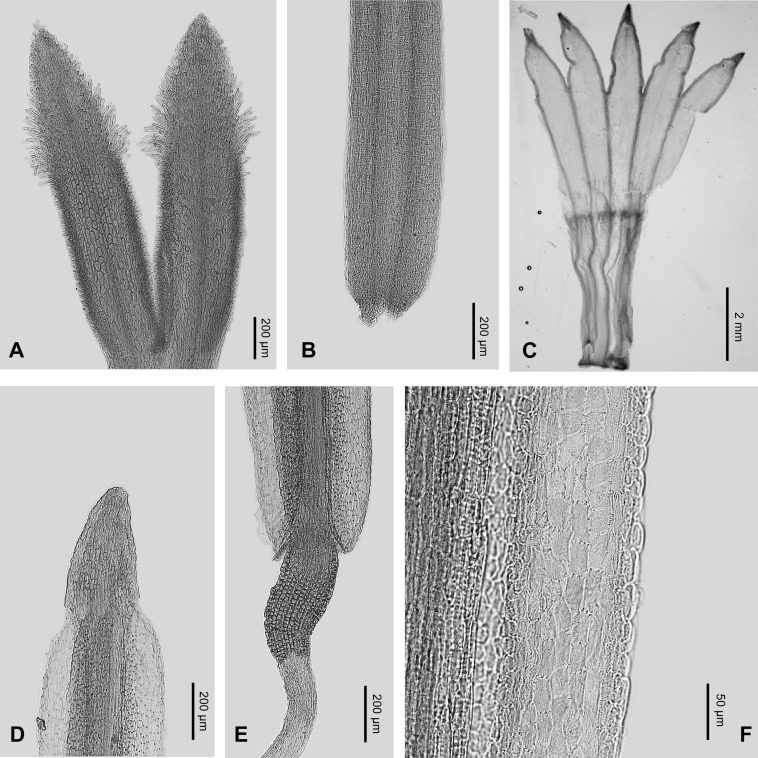
Micro-morphology of Aster dolichophyllus.(A) Style branches; (B) stylopodium; (C) corolla; (D) anther tip appendage; (E) anther base appendage, filament collar and anther endothecial tissue.